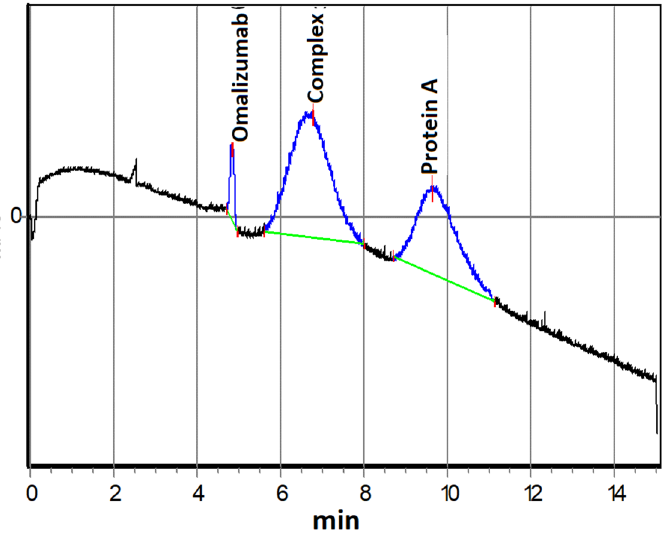
Figure 9. Electropherogram of a solution containing omalizumab (0.6 µM) and protein A (0.64 µM).